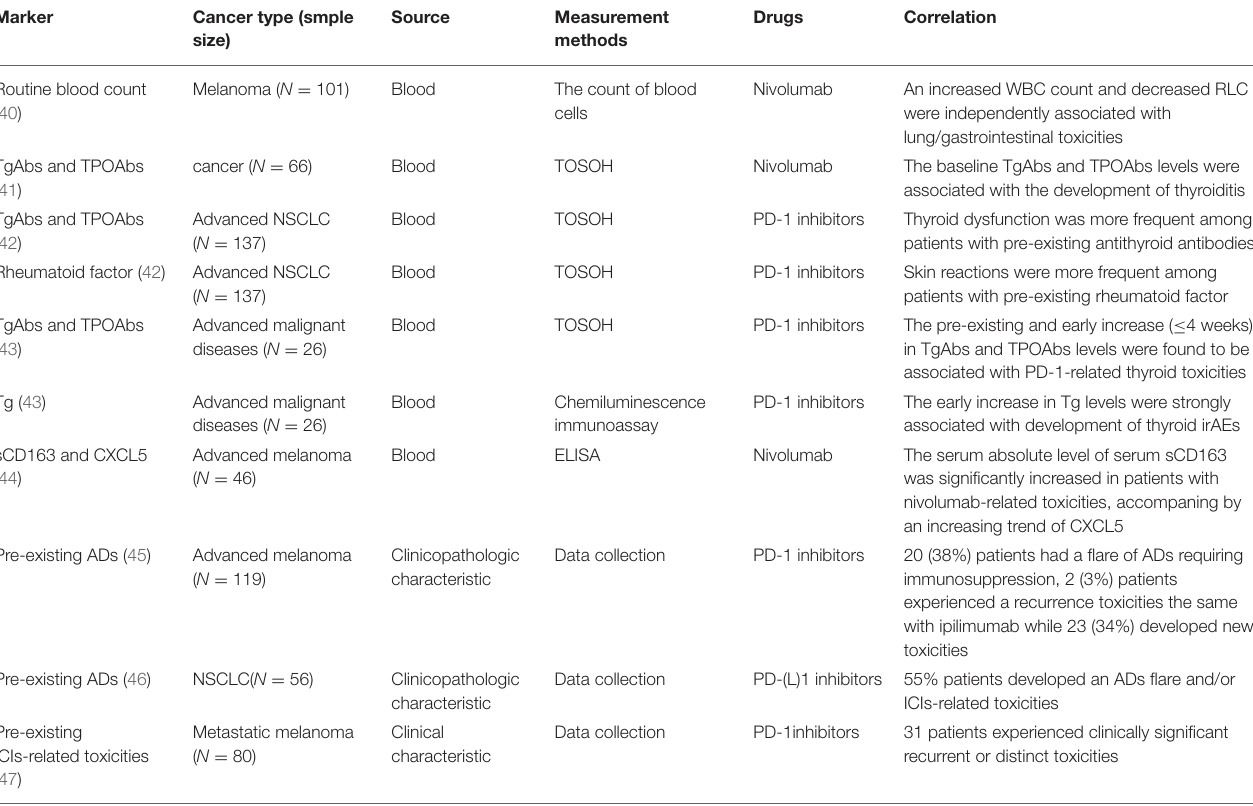
TABLE 2 | Predictive biomarkers for PD-1/PD-L1 inhibitors-related toxicities.